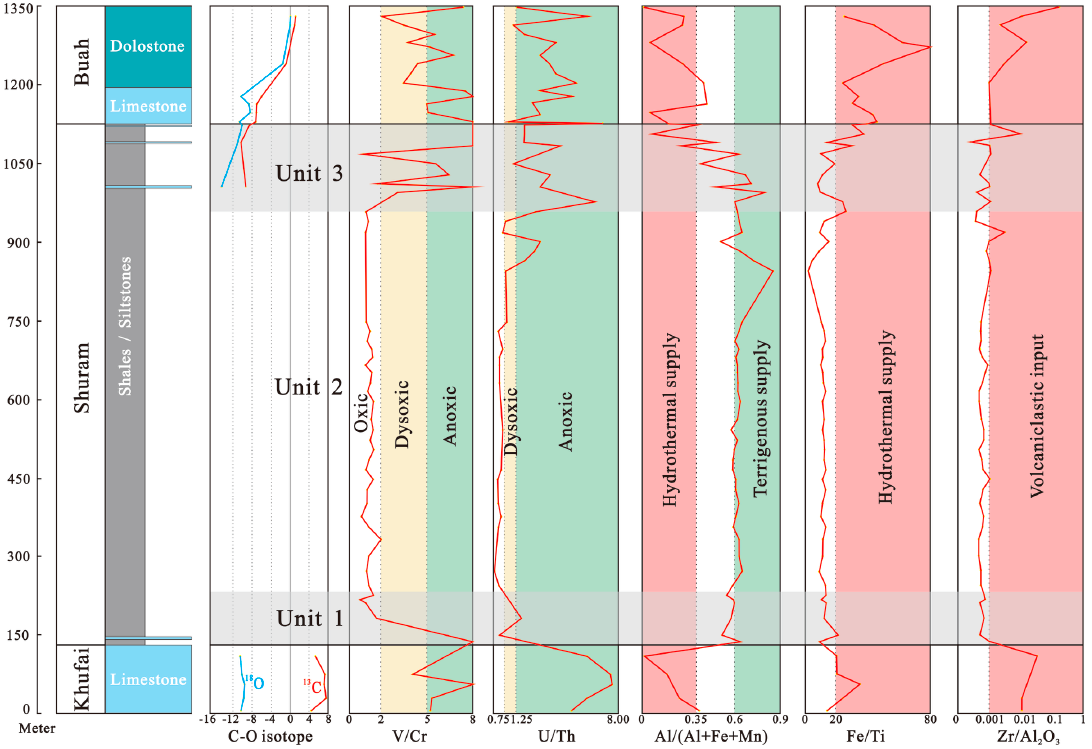
Figure 6. Geochemical environmental proxies for the Nafun Group.